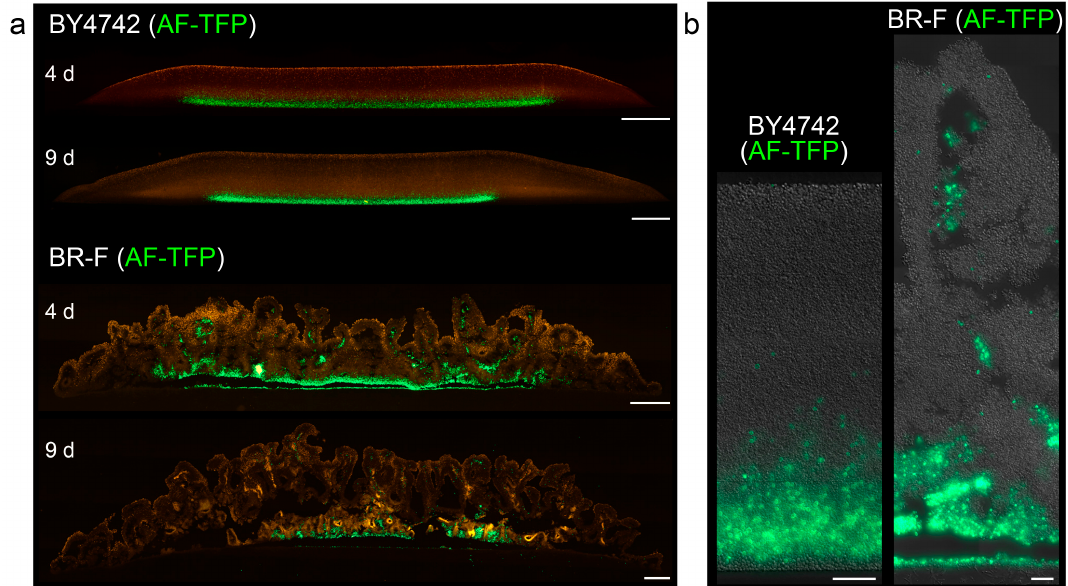
Figure 3. Distribution of cells stained with AlexaFluor488 5-TFP in giant colonies and colony biofilms. Cross-sections of whole 4 and 9-day-old smooth colonies (BY4742) and colony biofilms (BR-F) ( a ) and parts of the structures in higher magnification ( b ). In green, cells stained with AlexaFluor488 5-TFP (AF-TFP) used for inoculation. Offspring cells are indicated in false red: autofluorescence (a) and in differential interference contrast (DIC) (b) Bar, 500 μ m (a), 50 μ m (b). 2.3. Zebra vs. Leopard Cell Distribution Depends on Cell Adhesiveness, but Not on the Type of Cell Division or Cell Separation